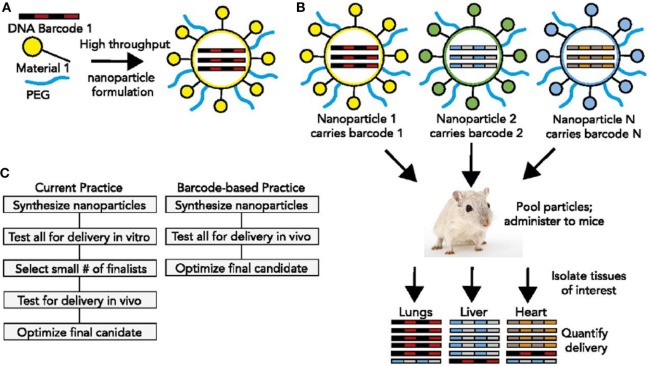
DNA barcoded nanoparticles for high-throughput in vivo nanoparticle delivery. (A) Using high-throughput fluidic mixing, nanoparticles are formulated to carry a DNA barcode. (B) Many nanoparticles can be formulated in a single day; each nanoparticle chemical structure carries a distinct barcode. Particles are then combined and administered simultaneously to mice. Tissues are then isolated, and delivery is quantified by sequencing the barcodes. In this example, nanoparticle 1 delivers to the lungs, nanoparticle 2 delivers to the liver, and nanoparticle N delivers to the heart. (C) This DNA barcode system enables multiplexed nanoparticle-targeting studies in vivo, improving upon the current practice, which relies on in vitro nanoparticle screening to identify lead candidates. Reproduced from Ref. (23) with kind permission by the National Academy of Sciences.